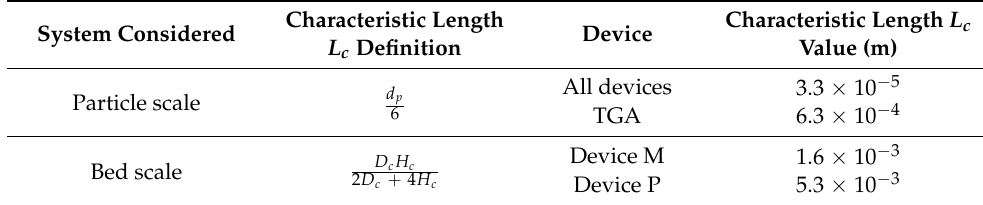
Table 6. Characteristic lengths used for characteristic time calculations with d p the particle diameter, D c the bed diameter, and H c the bed height.